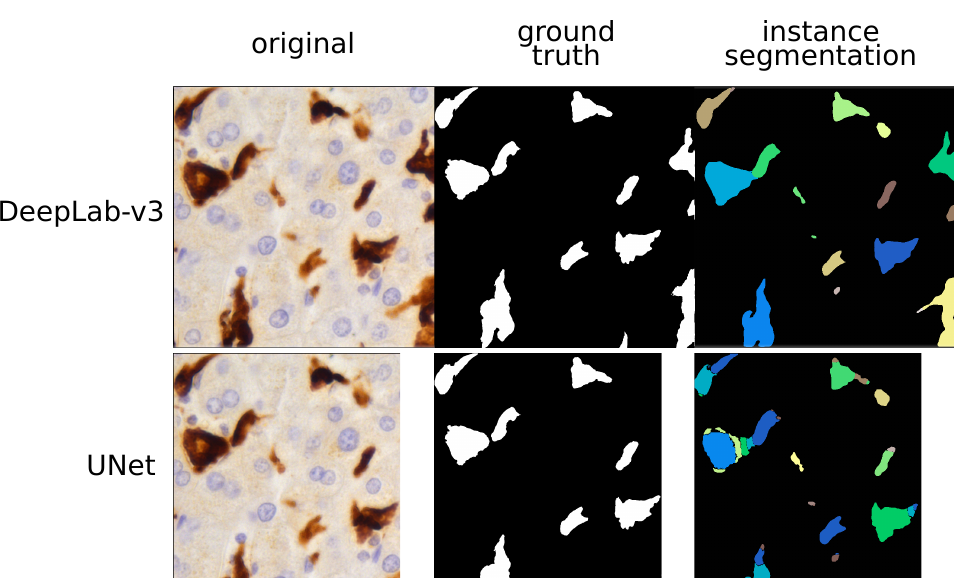
Figure 2. TAM segmentation: instance approach. This figure compares the histopathological image and the outputs given by two models (UNet and DeepLab-v3) using instance segmentation. Different predicted instances are color-coded and we can see that the UNet over-segments most of the TAMs. By contrast, the DeepLab-v3 model properly labelled each TAM as a single instance and did not produce any kind of